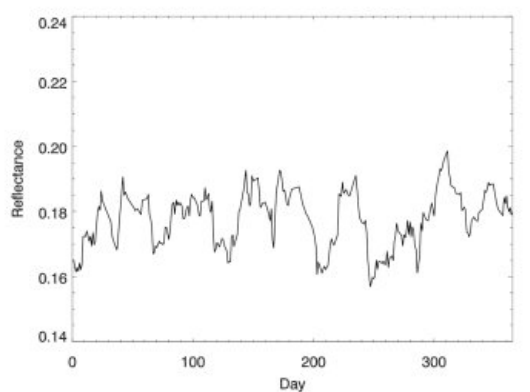
Figure 4. A time series of atmospherically corrected MODIS band 18 for 2009 representative of the Credo site.